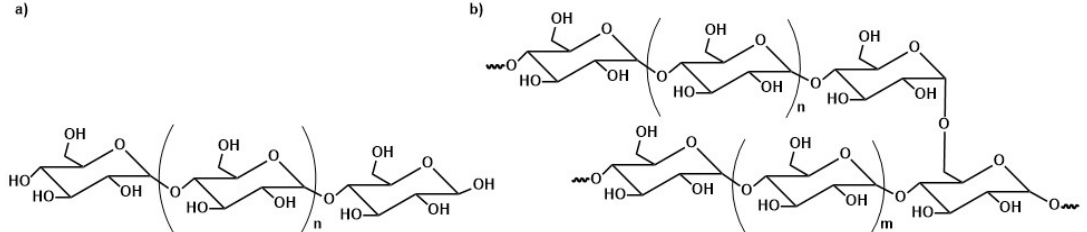
Figure 21. Chemical structure of starch components: ( a ) amylopectin and ( b ) amylose.